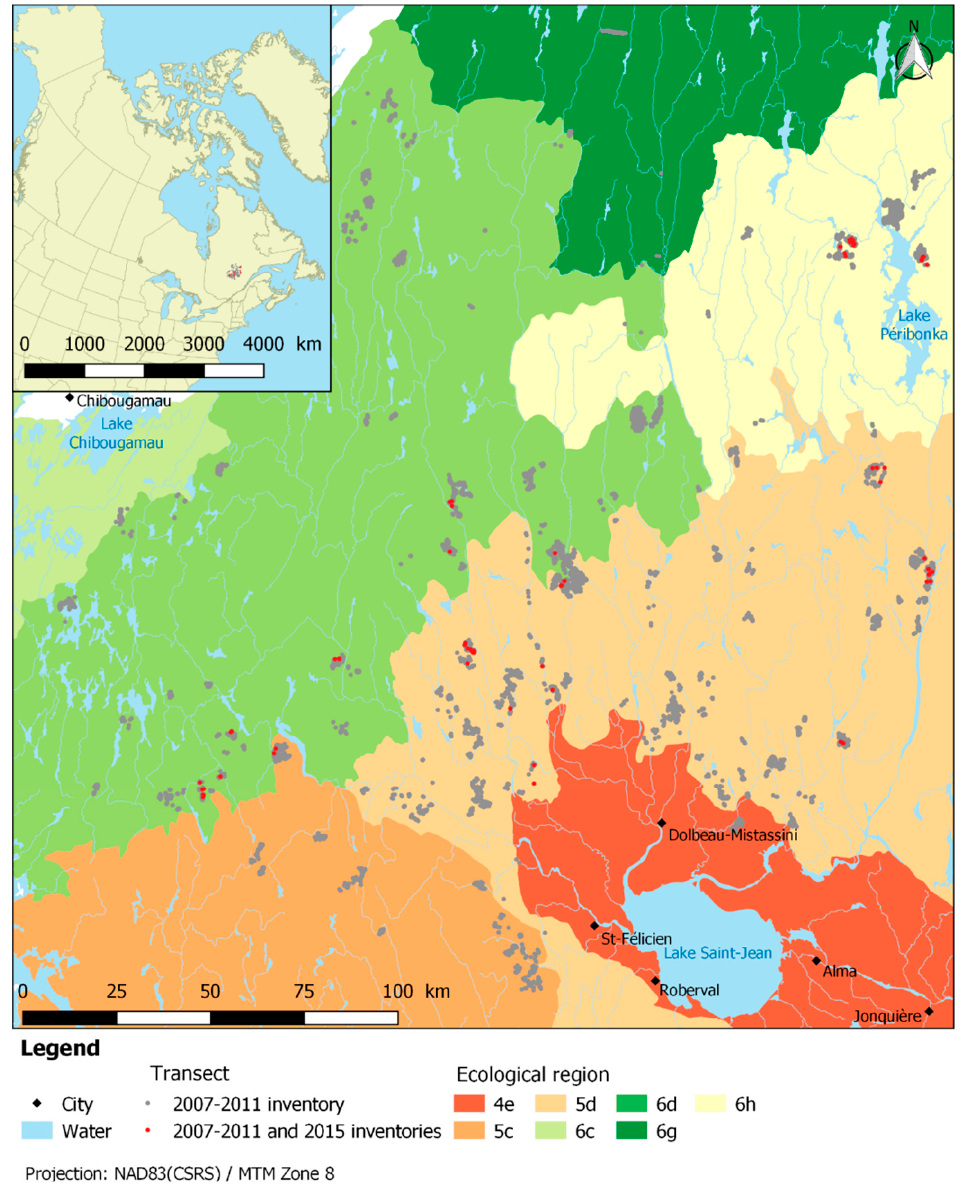
Figure 1. Location of the study area and sampling sites in Quebec (Canada). Gray dots represent transects from the 2007–2011 inventory and red dots represent transects that were re-sampled in 2015. Ecological regions are those defined by [16].